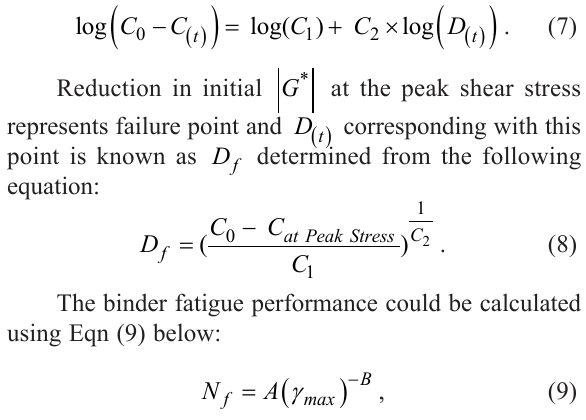
Fig. 1. Loading scheme in linear amplitude sweep